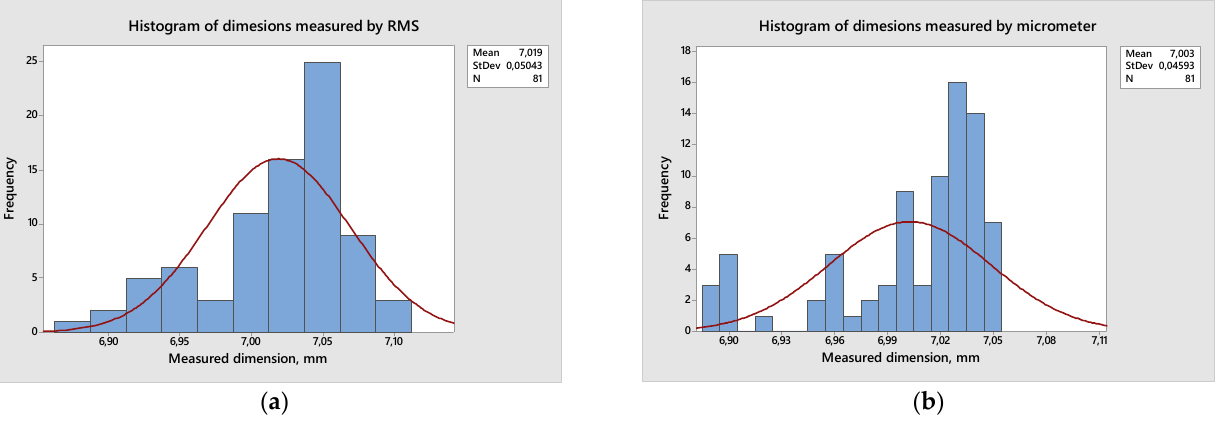
Figure 10. Histograms for two types of measurement of the same object (same dimension) with standard deviation and mean of 81 results: ( a ) histogram of RMS results; ( b ) histogram of micometer results. Figure 11 represents individual control charts for RMS and for micrometer measured values. In Figure 11a it shows that measured values with RMS are all between upper and lower control level and the range of levels are 0.29 mm. In micrometer, measured values control chart shows that some measured values are below lower control level, but the range of levels is 0.22mm. Also, the box plot in Figure 12 can be a good representation of the results, that RMS values are in a greater range but they are more